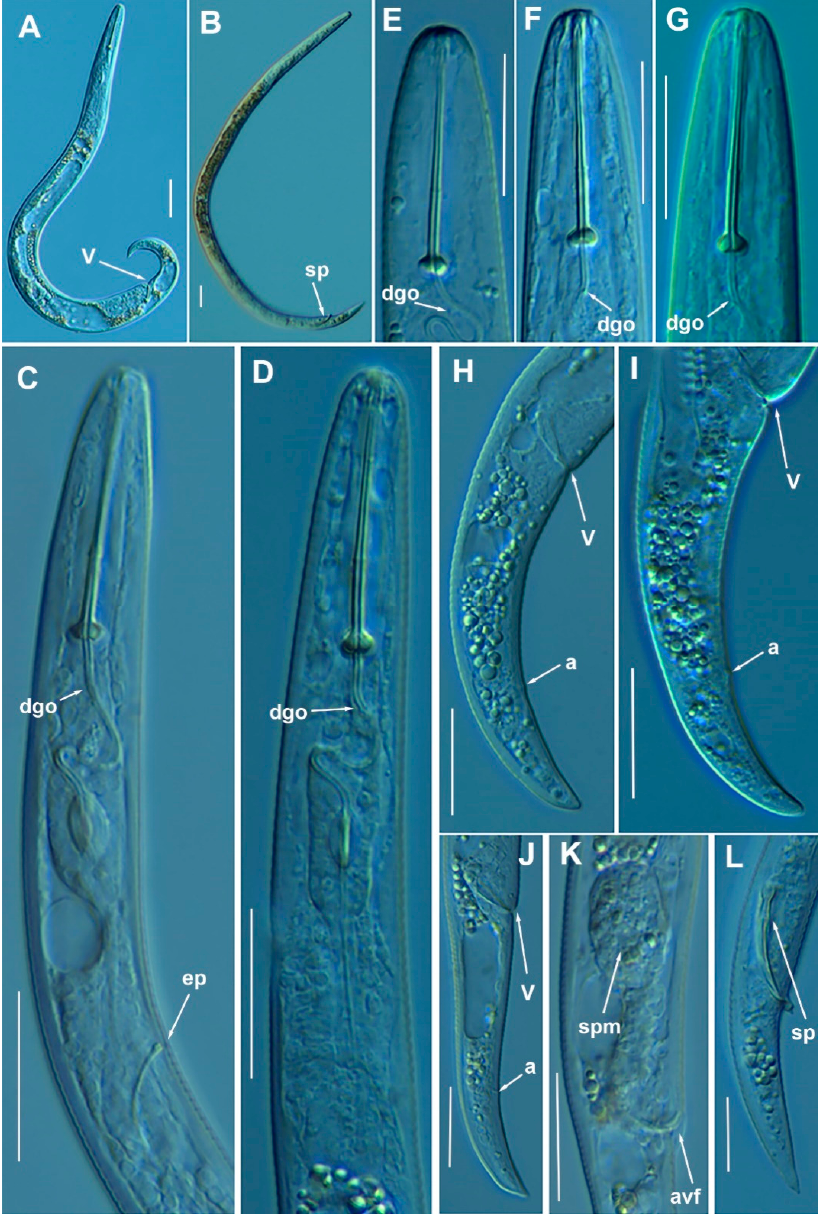
Figure 15. Light photomicrographs of Paratylenchus hamatus Thorne & Allen, 1950. ( A ): Entire female with vulva arrowed; ( B ): Entire male with spicules arrowed; ( C , D) : Female pharyngeal region; ( E – G ): Female lip region; ( H – J ): Female posterior region with vulva and anus (arrowed); ( K ): Detail of vulva showing spermatheca and advulval flap (arrowed); ( L ): Male tail with spicules arrowed. Scale bars ( A – L = 20 μ m). (Abbreviations: a = anus; avf = advulval flap; dgo = pharyngeal dorsal gland orifice; ep = excretory pore; spm = spermatheca; sp = spicules; V = vulva).